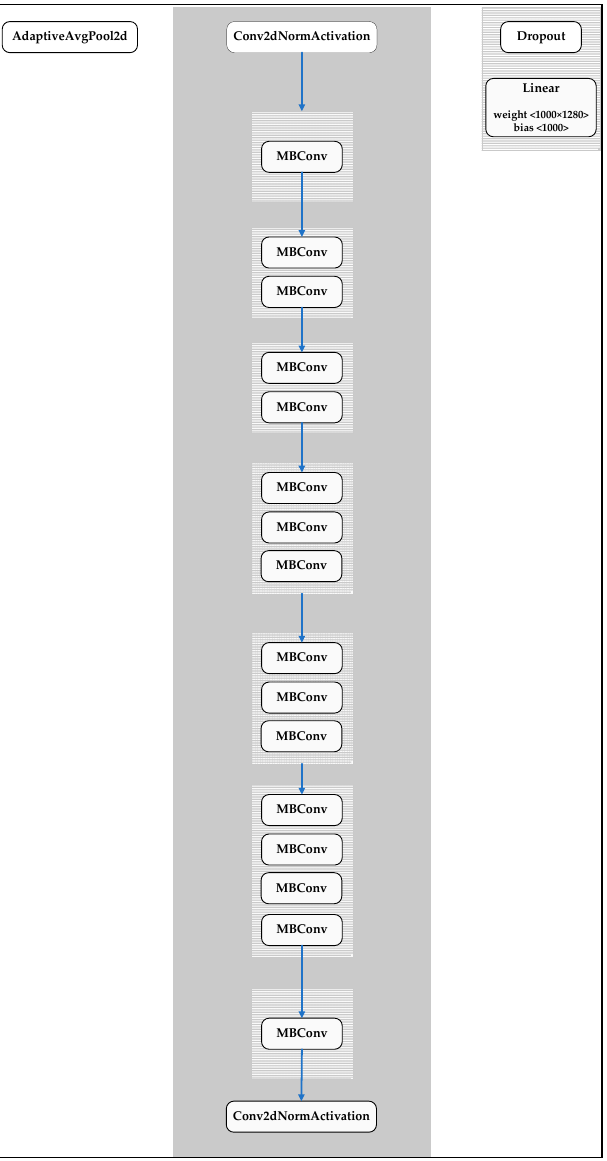
Figure 13. Structure of EfficientNet-B0.